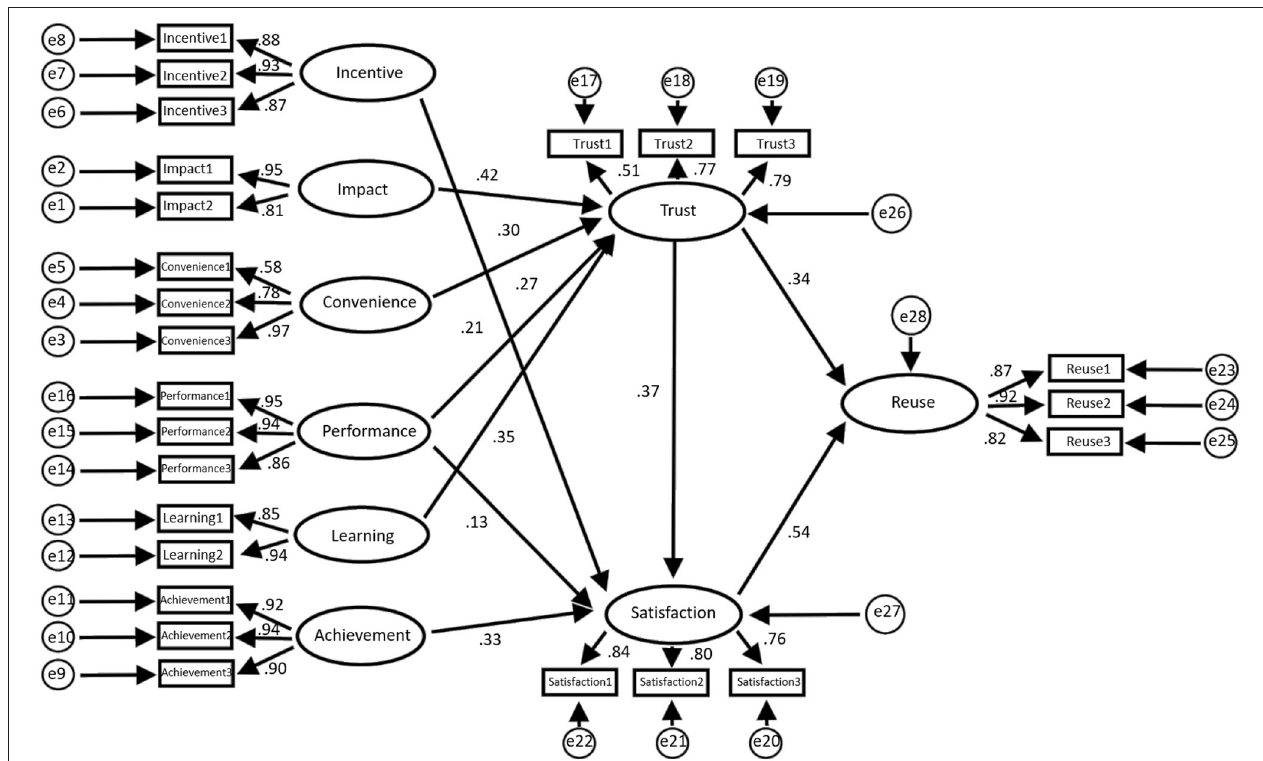
FIGURE 4 | Equation model of the construction agency regression